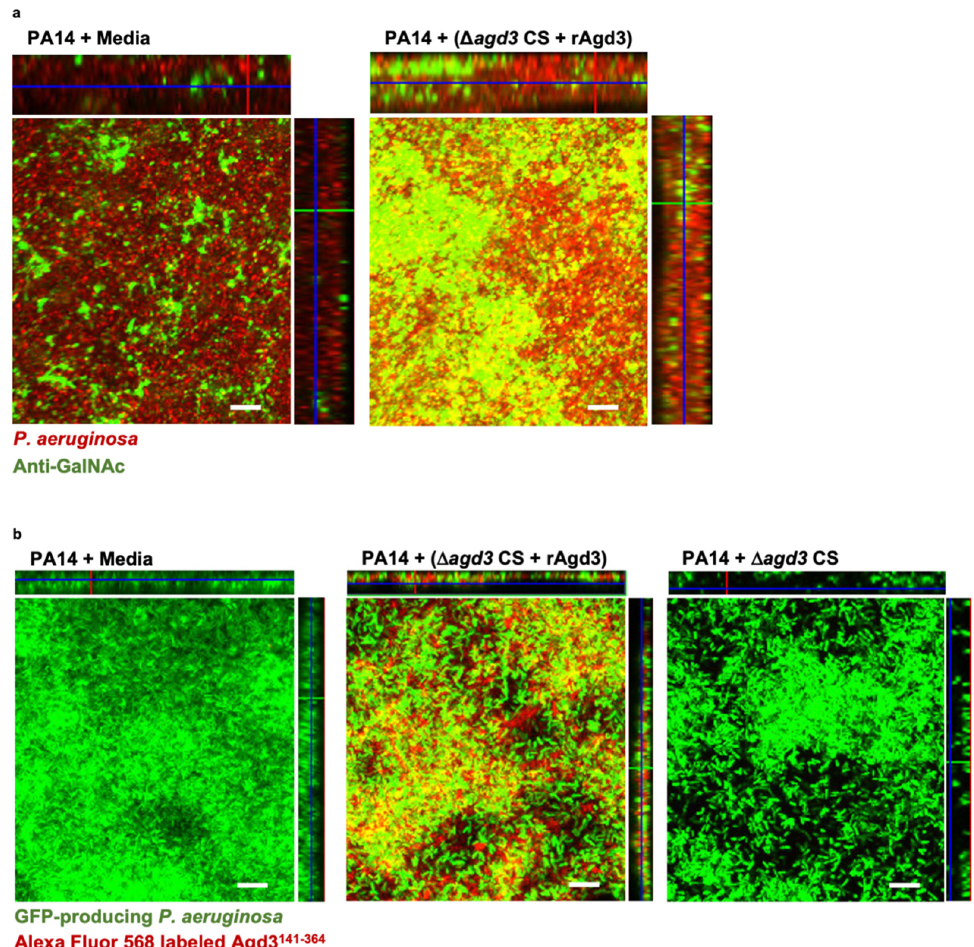
Figure 6. GAG incorporates into P. aeruginosa biofilms. ( a ) Confocal immunofluorescence microscopy maximal intensity projections with orthogonal projections of wild-type P. aeruginosa (PA14) biofilms grown in the presence of de- N -acetylated GAG from a combination of N -acetylated GAG-containing culture supernatants and 165 nM recombinant Agd3 deacetylase ( ∆ agd3 CS + rAgd3) or media. Exopolysaccharide was detected by staining with anti- N -acetyl-D-galactosamine antibody (anti-GalNAc) and an Alexa Flour-488 conjugated anti-rabbit secondary antibody (green). P. aeruginosa was counter stained with DRAQ5 (red). ( b ) Confocal microscopy maximal intensity projections with orthogonal projections of wild-type green fluorescent protein (GFP)-producing (green) P. aeruginosa (PA14) biofilms grown in the presence of de- N -acetylated GAG from a combination of ∆ agd3 CS and 165 nM rAgd3, ∆ agd3 CS alone or in media. Biofilms were imaged with fluorescence microscopy. Exopolysaccharide was detected by staining with Alexa Flour-568-labeled recombinant carbohydrate binding module Agd3 141-364 (red). Representative images of 3 independent experiments. Biofilms were imaged at 630× (scale bar, 10 μ m).